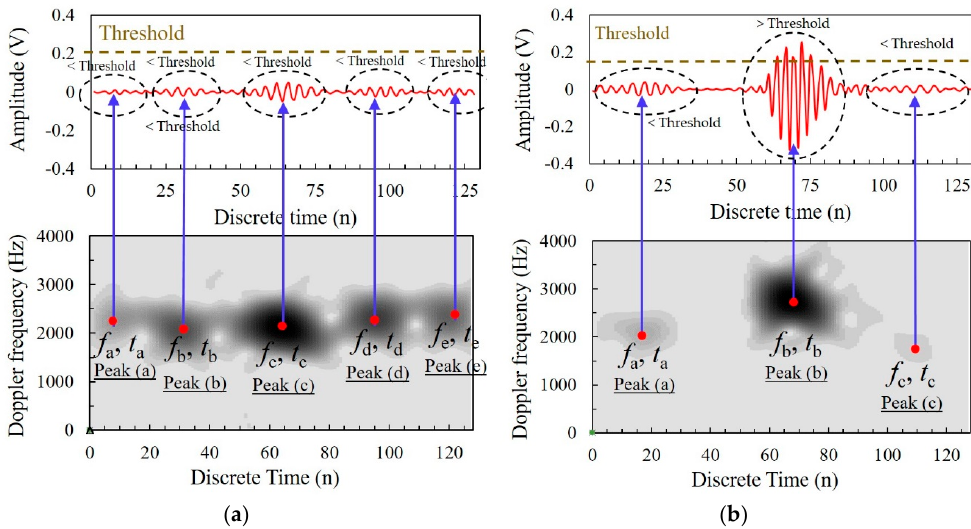
Figure 9. Example of the Doppler frequency classification for proposed technique: ( a ) single ‐ phase flow (only particle), ( b ) two ‐ phase bubbly flow (with particle and bubble).